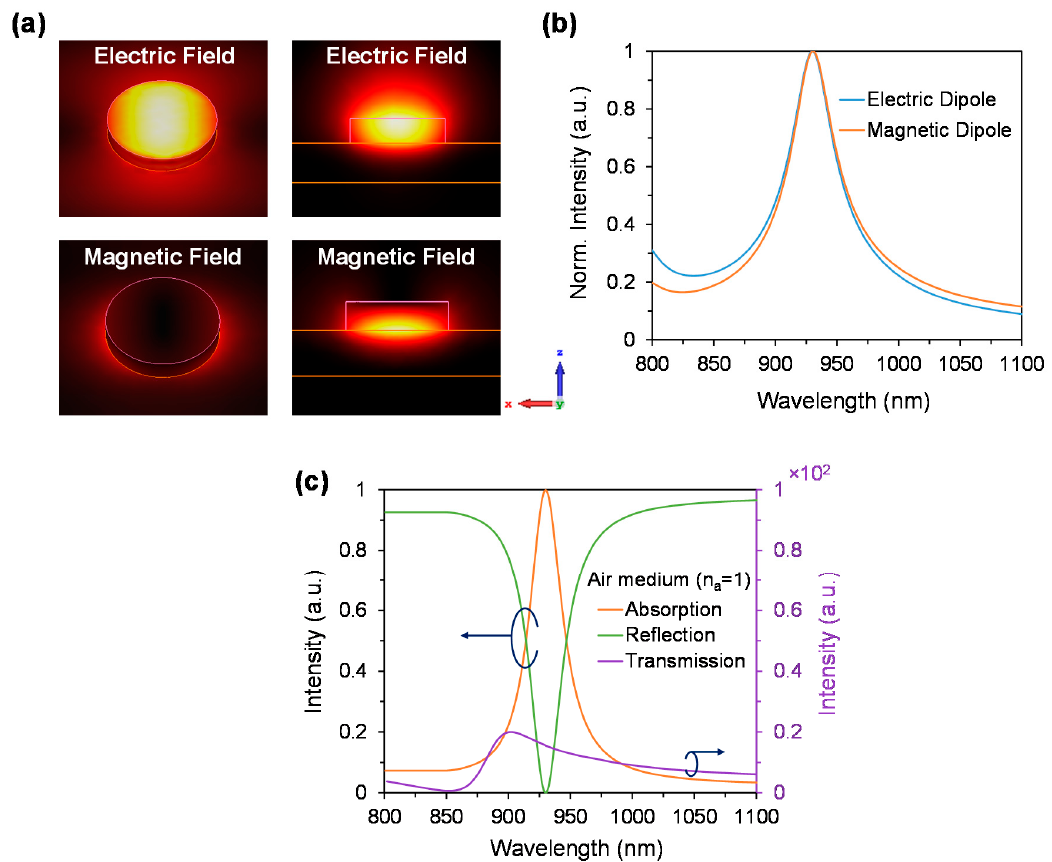
Figure 2. ( a ) Electric and magnetic fields distribution of the proposed metasurface absorber in air superstrate. The nanodisk diameter is d = 230 nm; thickness, h = 50 nm and period, p = 670 nm. ( b ) Resonant overlap of electric and magnetic dipoles, resulting in impedance matching phenomenon, and ( c ) Absorption, reflection and transmission spectra of the proposed metasurface in air-medium